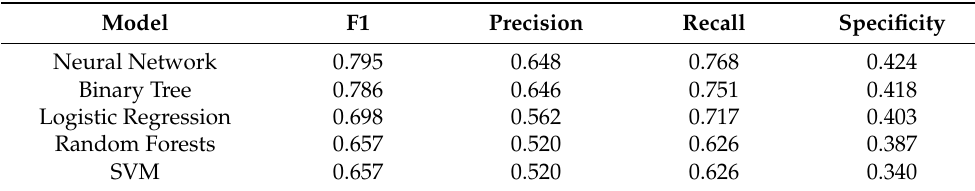
Table 18. Models accuracy metrics for not adding product from recommending interface (class 0) with add_to_cart_indirect as target